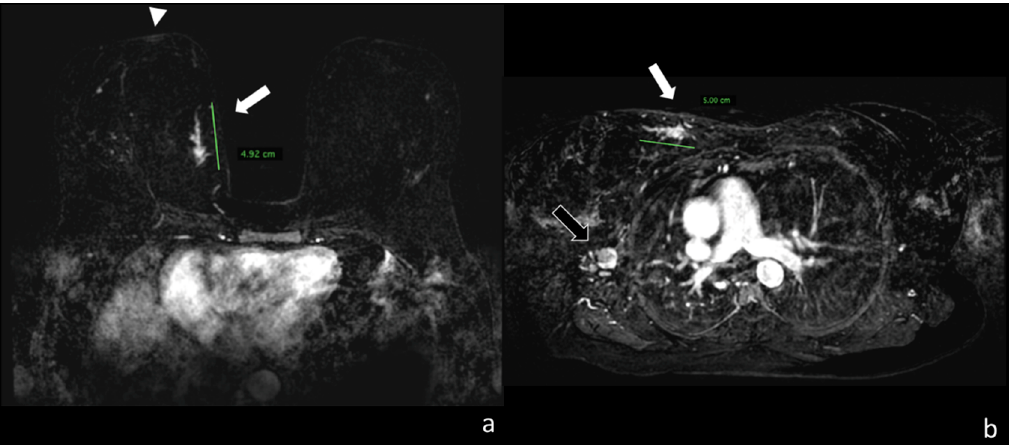
Figure 4. ( a ) Image taken from the first dynamic sequence performed in the prone position showing the nipple area (arrowhead). At the confluence of the internal quadrants of the right breast it shows a linear pathological impregnation of the contrast medium measuring around 4.92 cm, which histological analysis identified as a ductal carcinoma infiltrating and in situ (white arrow). ( b ) Image taken from the first dynamic sequence performed on the same patient in the supine position, showing how the lesion is localized in the upper internal quadrant of the right breast (see the mediastinum) with a similar extension of around 5.00 cm (white arrow). Note how in the supine position, the secondary localization in the same layer appears in the site of the right axilla (black